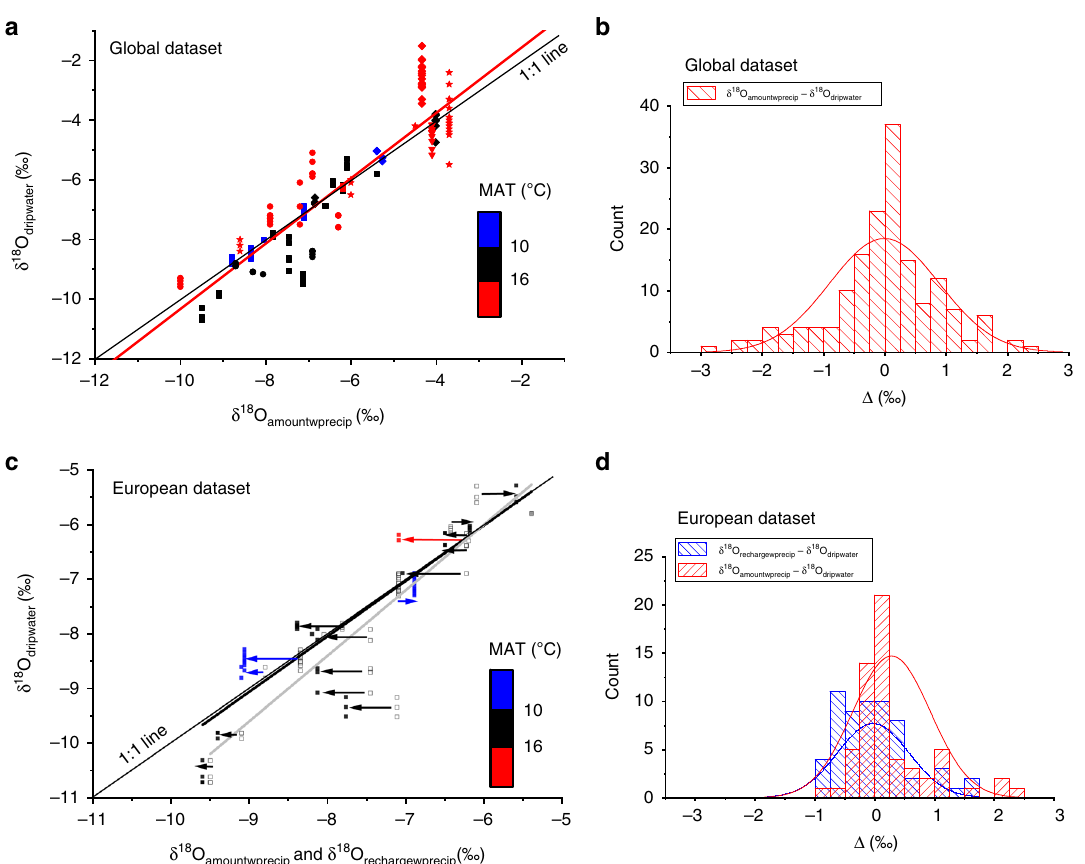
Fig. 2 Global oxygen isotope relationships. a Global relationship between δ 18 O dripwater and δ 18 O amountwprecip . The global data set regression line is shown in red: δ 18 O dripwater = 0.64 (±0.25) + 1.10 ( ± 0.04) δ 18 O amountwprecip ( ‰ ). Sites are coloured according to their mean annual temperature and symbols show their region: Europe (squares), China (circles), Australia (diamonds), United States (triangles) and other (stars). b Frequency histogram for the global data set for the difference between δ 18 O amountwprecip and δ 18 O dripwater ( Δ awp-dw ). c Relationship between the δ 18 O rechargewprecip , δ 18 O amountwprecip and δ 18 O dripwater for the European data set. The amount-weighted data are shown in open black symbols, and the regression line is shown in gray: δ 18 O dripwater = 1.19 (±0.59) + 1.20 (±0.08) δ 18 O amountwprecip ( ‰ ). The recharge-weighted data are shown by coloured symbols (as for ( a )) and the regression line is shown in black: δ 18 O dripwater = 0.06 (±0.50) + 1.01 (±0.06) δ 18 O rechargewprecip ( ‰ ). The arrows show the direct effect of recharge weighting. d Frequency histogram for the European data set for the difference between δ 18 O rechargewprecip and δ 18 O dripwater ( Δ rwp-dw ) and δ 18 O amountwprecip and δ 18 O dripwater ( Δ awp-dw ) for the European data. Typical analytical uncertainties for individual δ 18 O analyses are ± 0.2 ‰